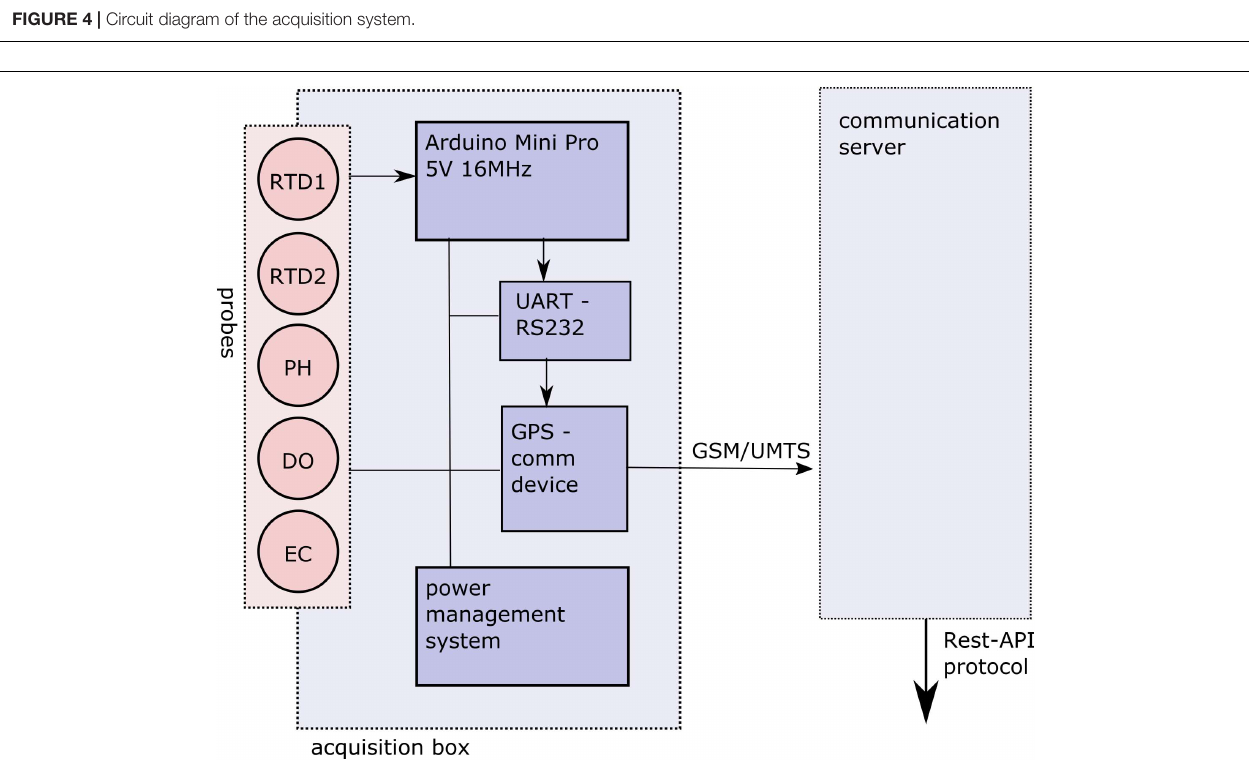
available but with a higher cost compared to solar